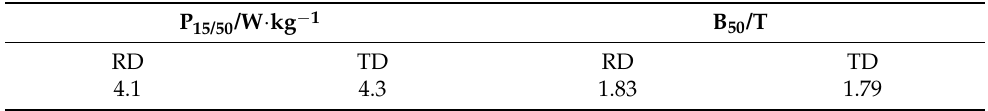
Table 3. Magnetic properties of 0.35 mm strip-cast annealing specimen. Adapted with permission from ref. [20]. 2021